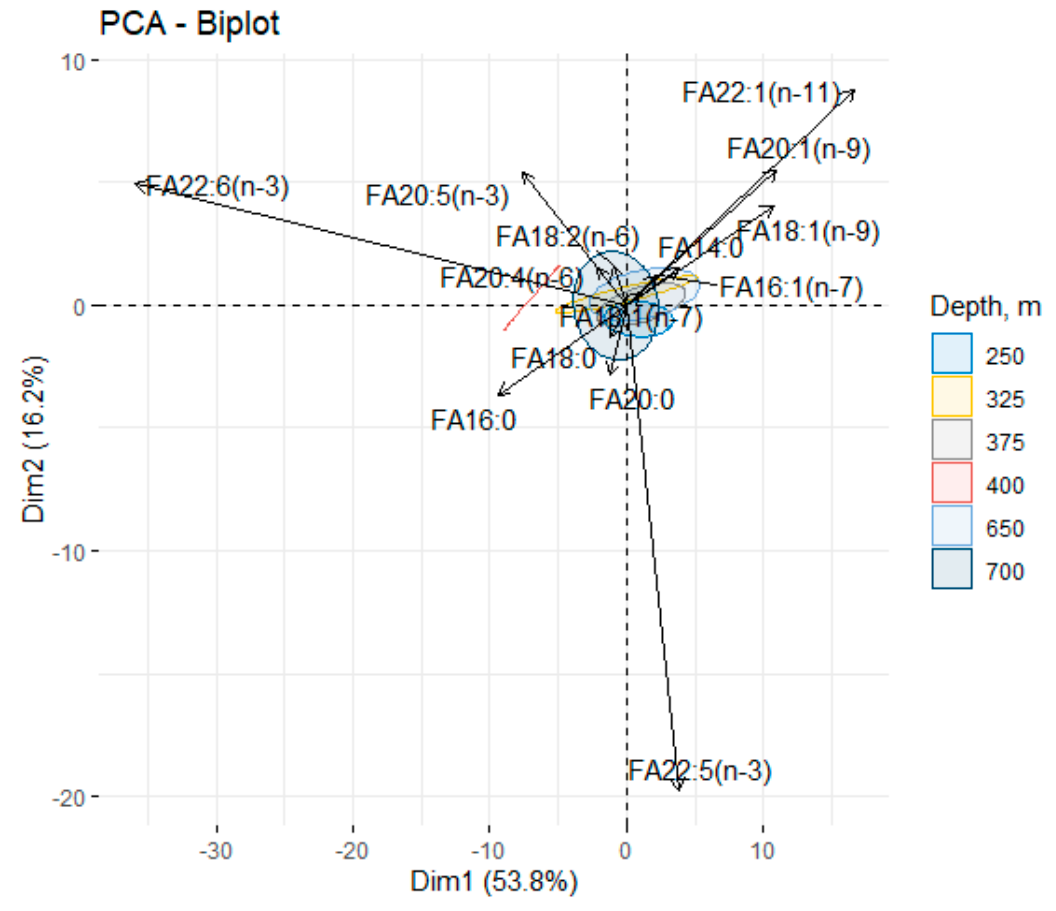
Figure 6. Principal component analysis of the fatty acid composition in the muscle tissue of male and female beaked redfish, Sebastes mentella, in the depth gradient of the Irminger Sea (North Atlantic).